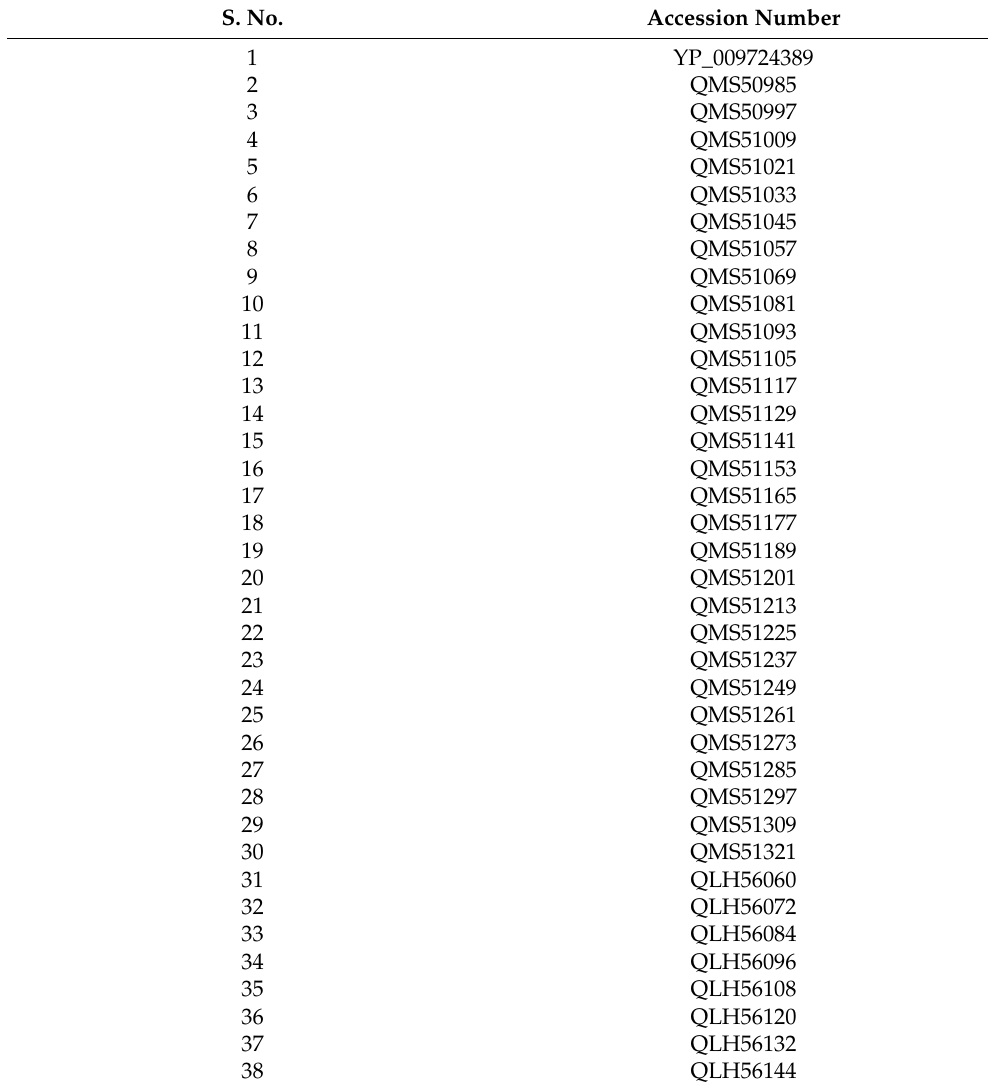
Table 1. Details of SARS-CoV-2 ORF1ab polyprotein sequences used in the analysis. S.